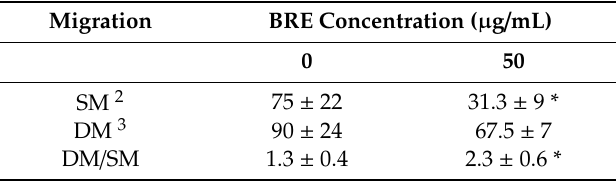
Table 3. Influence of BRE on PMNs chemotaxis 1 .